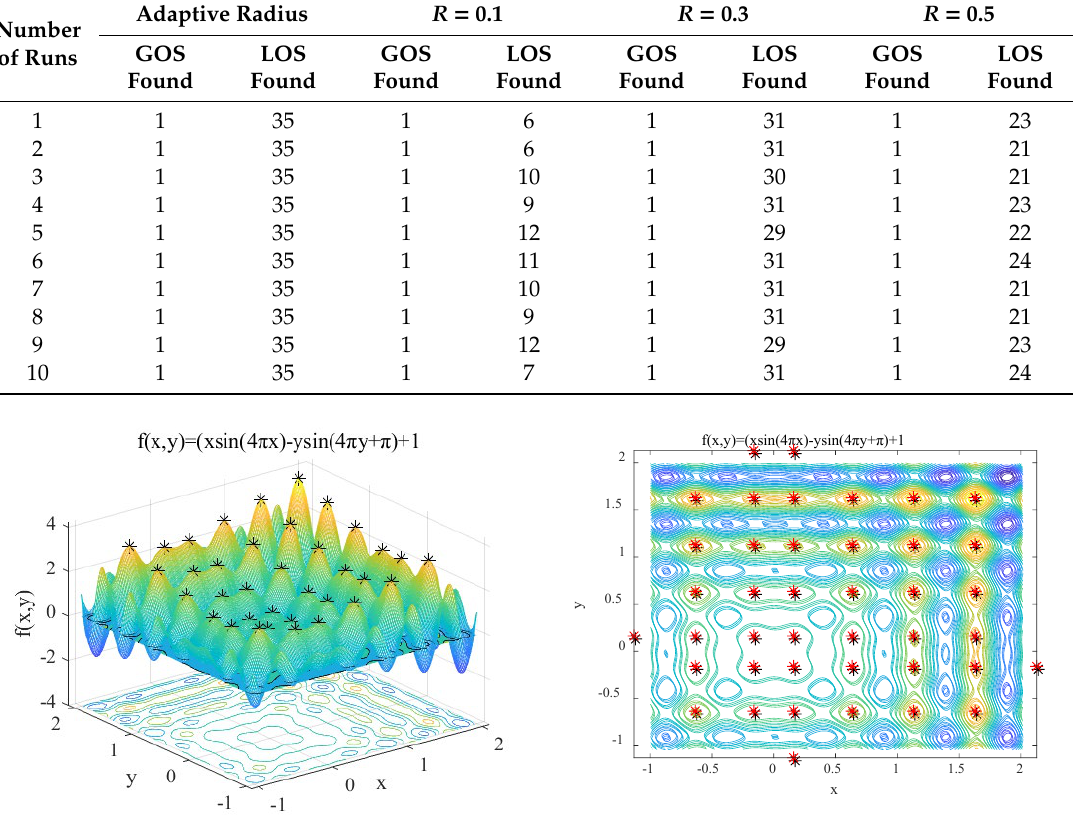
Table 3. Results of optimizing f 2 with different niche radius.